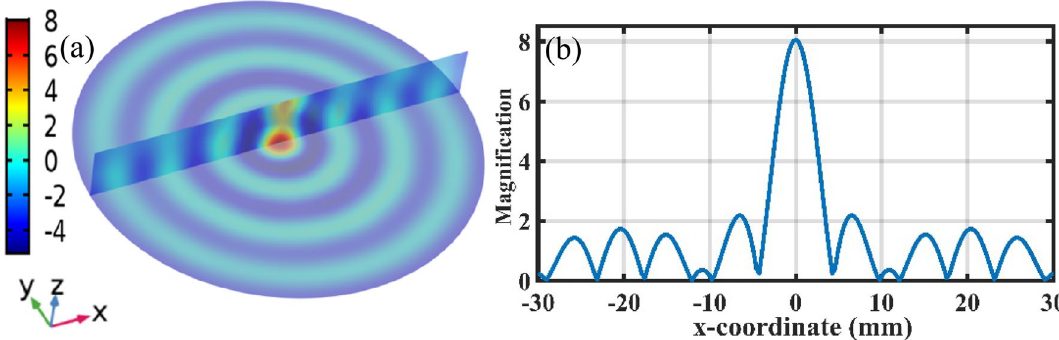
Figure 5. ( a ) Ultrasonic pressure distribution of the FZP in the focal and the z-axis plane. ( b ) The magnification of the FZP along the x-axis of the focal plane.